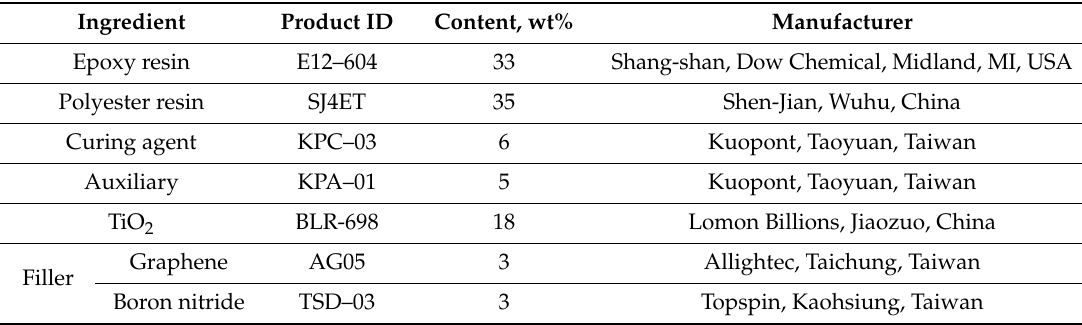
Table 2. Composition of powder